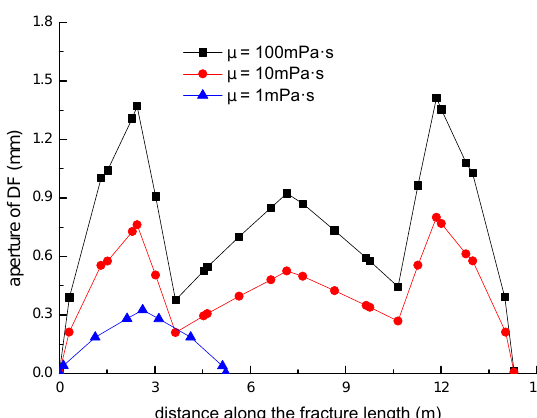
Figure 22. The fracture aperture curves of the DF along the fracture length at different levels of viscosity of fracturing fluid. The distance in the x -axis is along the direction from the lower part to the upper part of the DF.